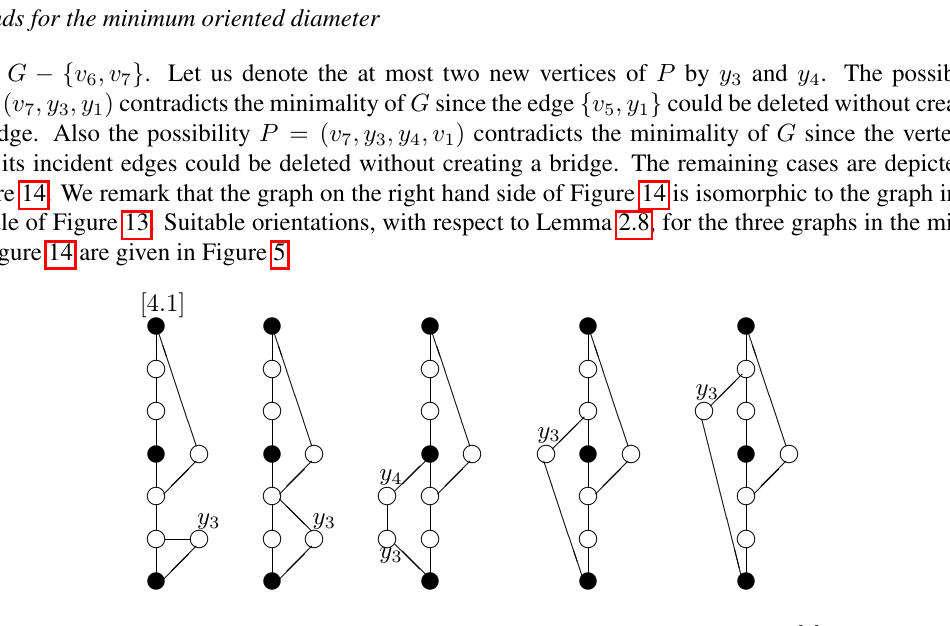
Fig. 14: (Almost) fixing v 7 for a maximum backbone tree of type 1 in case [4]